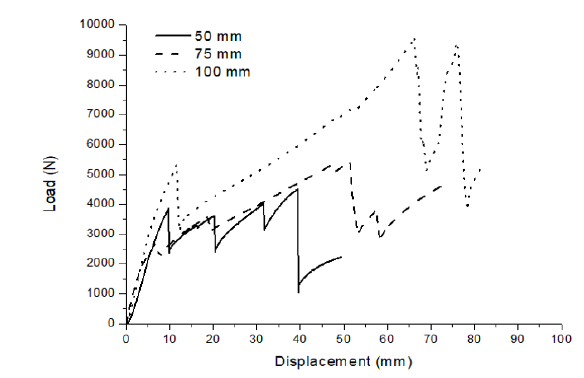
Fig. 8. Load-Displacement of Sandwich Panel